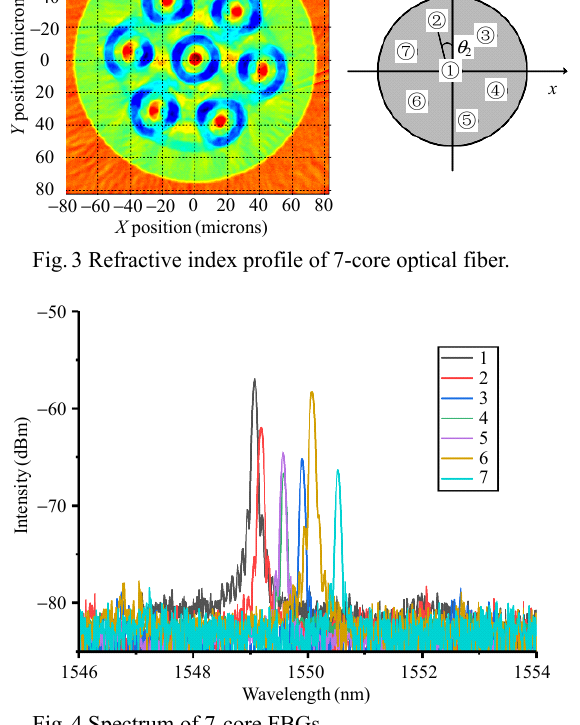
Fig. 4 Spectrum of 7-core